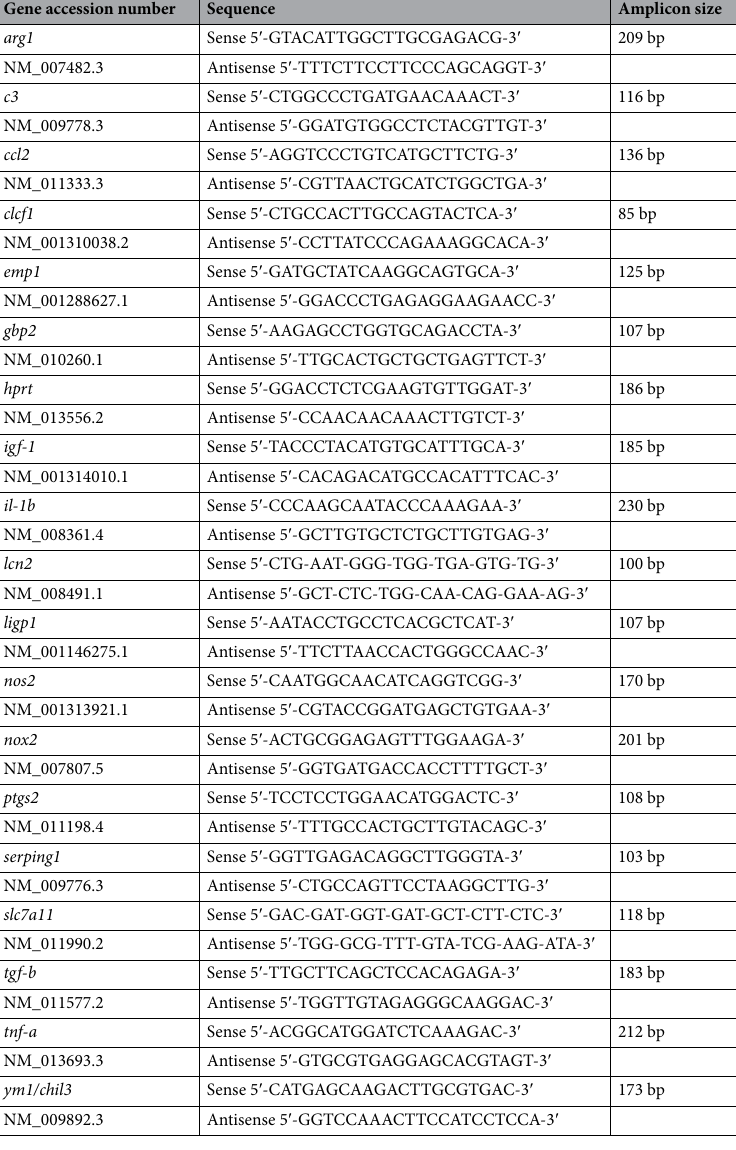
Table 3. List of